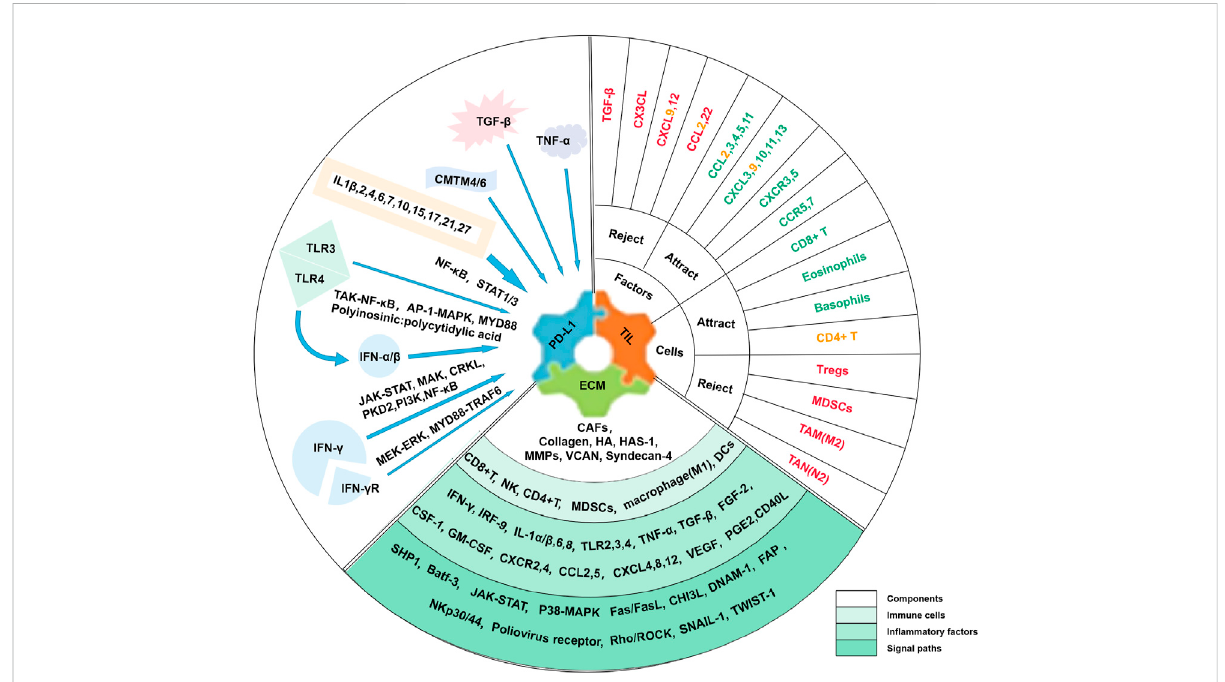
FIGURE 1 In fl uence of In fl ammatory Factors on Responses to ICIs in TME. In the TME, in fl ammatory factors affecting tumor response to ICIs were mainly associated with three factors, including PD-L1 abundance, TIL density, and ECM status. Many in fl ammatory factors affect PD-L1 expression, such as IFN- γ .In fl ammatory factors andimmunecells arebothinvolvedinin fl uencing TILin fi ltration with differentroles.Amongthem, greenfactors or cells attract T cells to homing or promote TIL in fi ltration, while red ones reject T cell homing or inhibit TIL in fi ltration. Factors or cells that are yellow have been reported to have a dual effect. Factors affecting ECM status include biological and physical factors, and the components, immune cells and in fl ammatory factors, and signal paths involved are